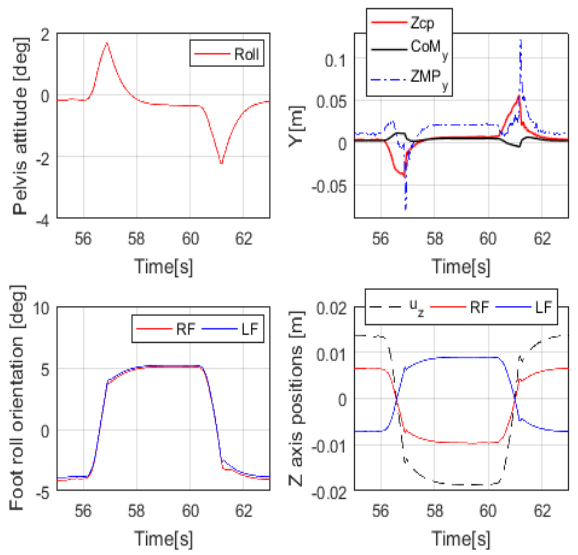
Figure 16. Experimental results from the robot on a varying incline.